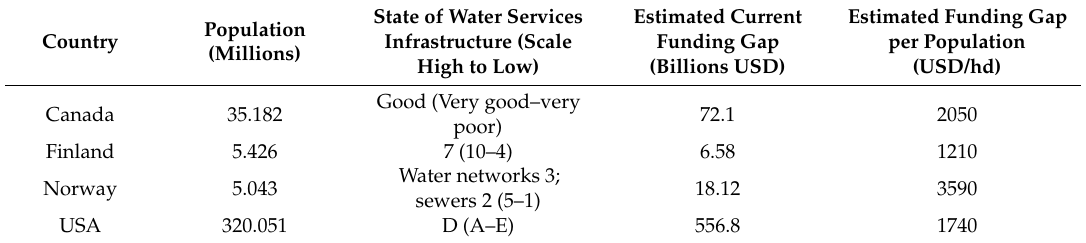
Table 1. Estimated investment gap in water services infrastructure in four selected OECD countries [28].